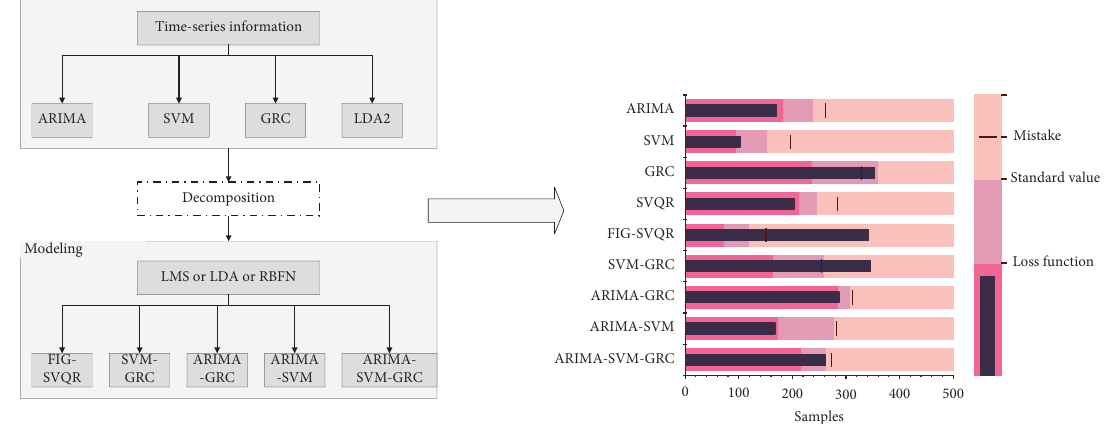
Figure 6: Variation of loss function values for each